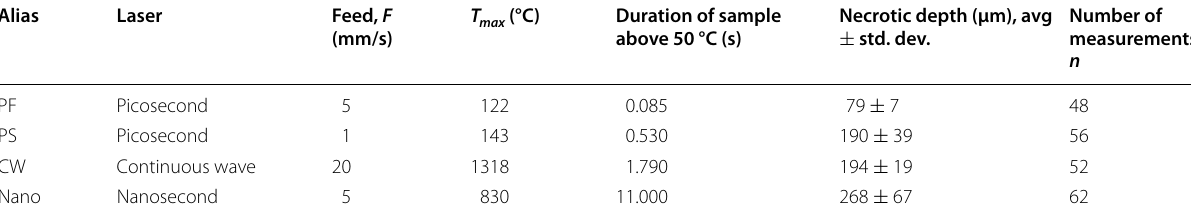
Table 3 Necrotic depth for all the laser